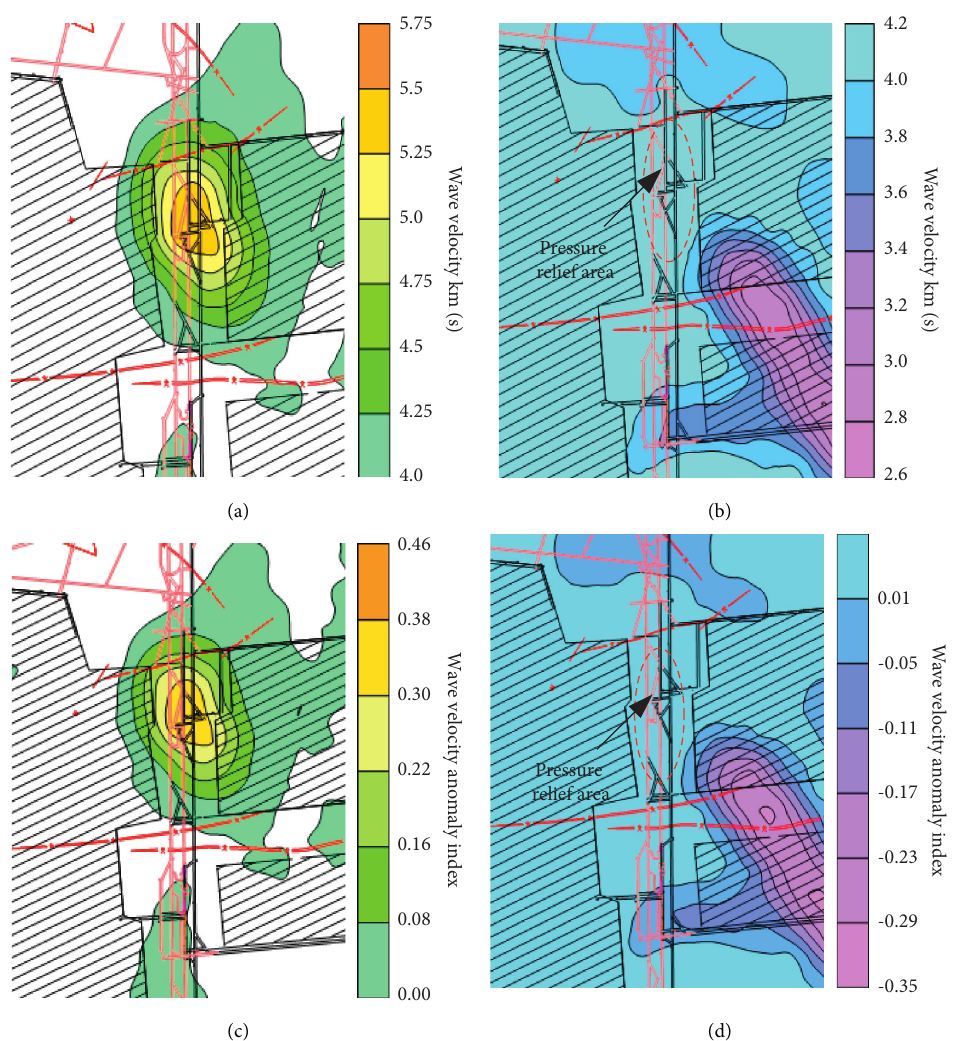
Figure 21: Seismic CTdetection results before and after decompression in the I-I section area of the isolated coal pillar. (a) Characteristics of wave velocity distribution before decompression (2018.09.05–2018.09.24). (b) Characteristics of wave velocity distribution after decon- fliction (2018.09.30–2018.10.18). (c) Distribution characteristics of wave speed anomaly index ( A n ) before decompression. (d) Distribution characteristics of wave speed anomaly index ( A n ) after